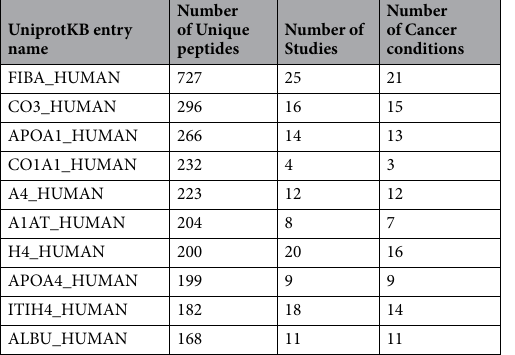
Table 2. Top ten proteins with maximum numbers of reported peptides in